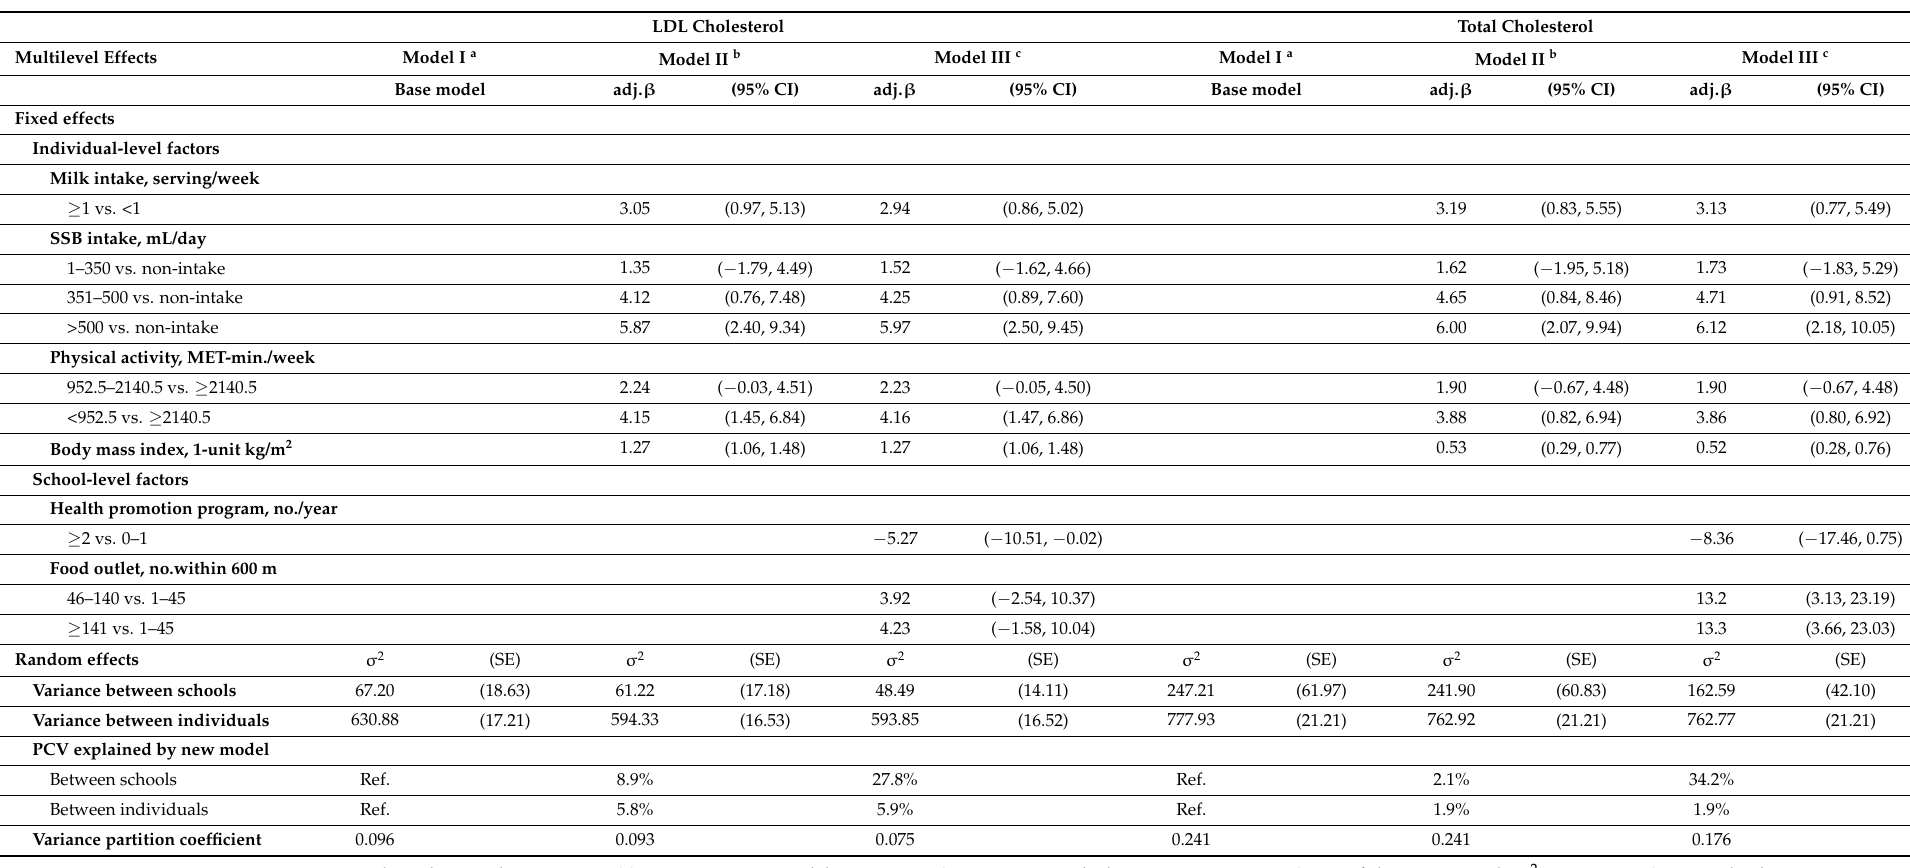
Table 6. The multilevel effects of individual and school factors on low-density lipoprotein and total cholesterol level (mg/dL) in